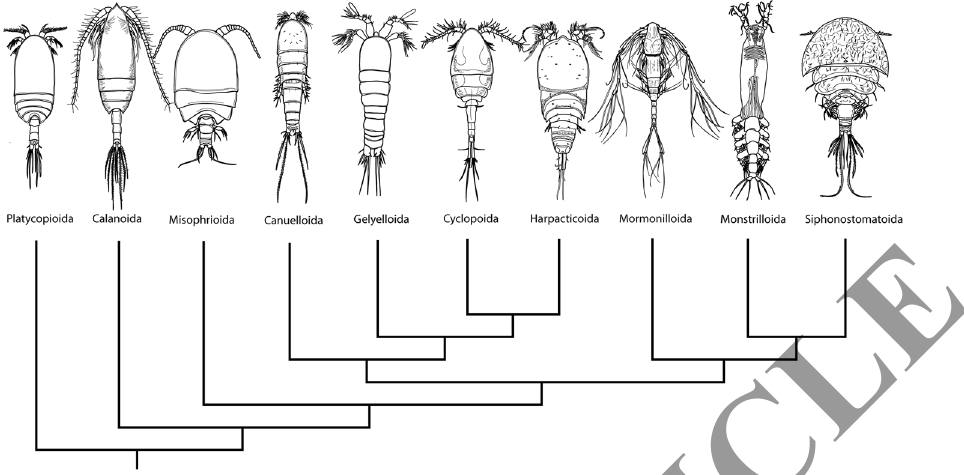
Figure 4. New phylogram of copepod Orders. Copepods redrawn from originals: Platycopioida, Calanoida, Canuelloida and Cyclopoida from Sars 19, 30, 82 ; Misophrioida from Martinez Arbizu and Jaume 83 Harpacticoida from Kihara and Martinez Arbizu 84 , Monstrilloida from 85 , Mormonilloida from Huys et al . 86 , Gelyelloida from Rouch and Lescher-Moutoué 73 and Siphonostomatoida from Boxshall and Huys 87